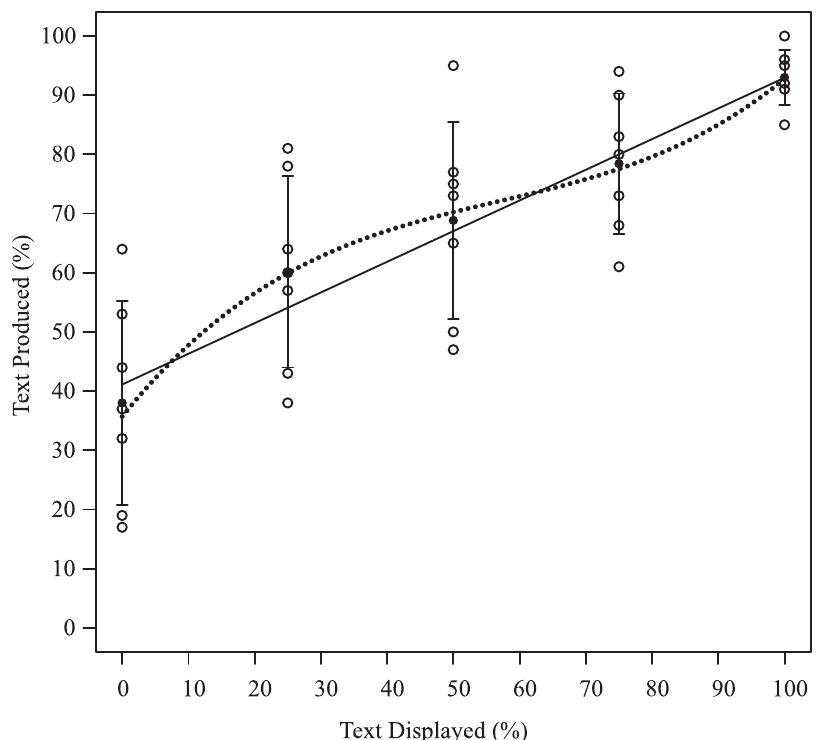
Figure 3. Influence of % ‘Text Displayed’ on % ‘Text Produced’. Circles represent proportion for each of the 7 sessions in the 5 conditions (summed across all questions asked). Disks represent the mean over the 7 sessions and error bars are + / 2 standard deviation for % ‘Text Produced’ in each of the five experimental conditions (0, 25, 50, 75 and 100% ‘Text Displayed’). The solid line represents the linear fit and the dotted line the cubic fit using the parameters in Table 3.